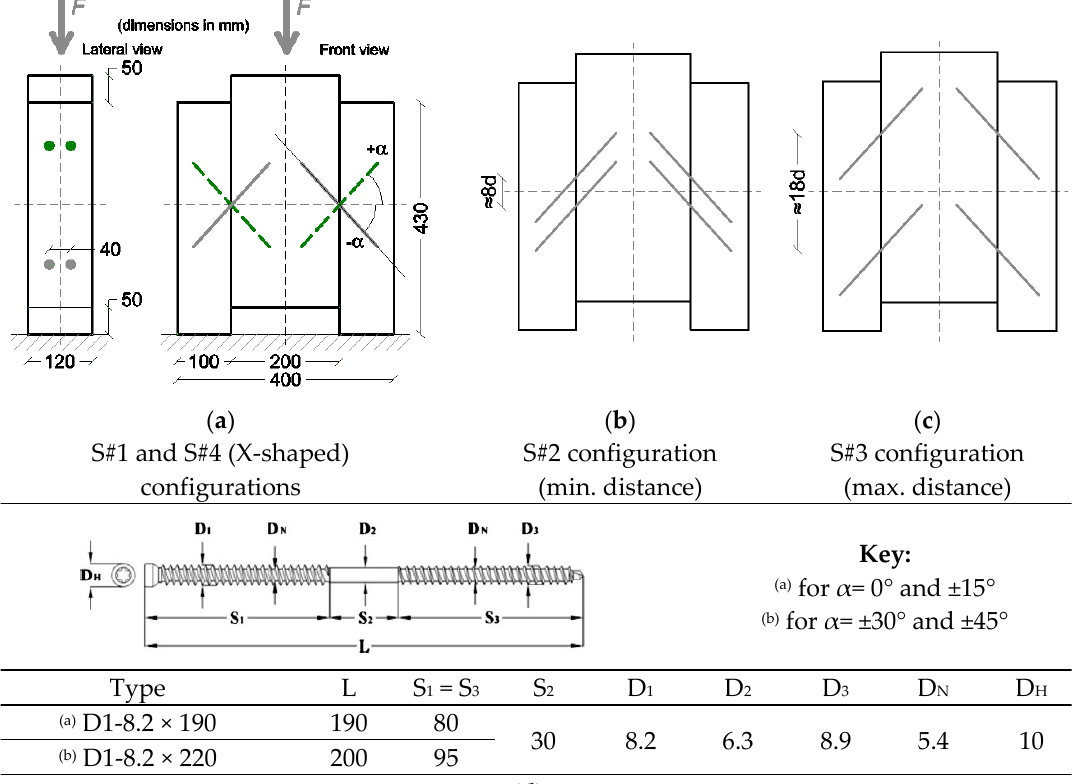
Figure 3. TTC joints with inclined STSs under a standard PO setup. ( a )–( c ): selected configurations and ( d ) nominal dimensions (in mm).